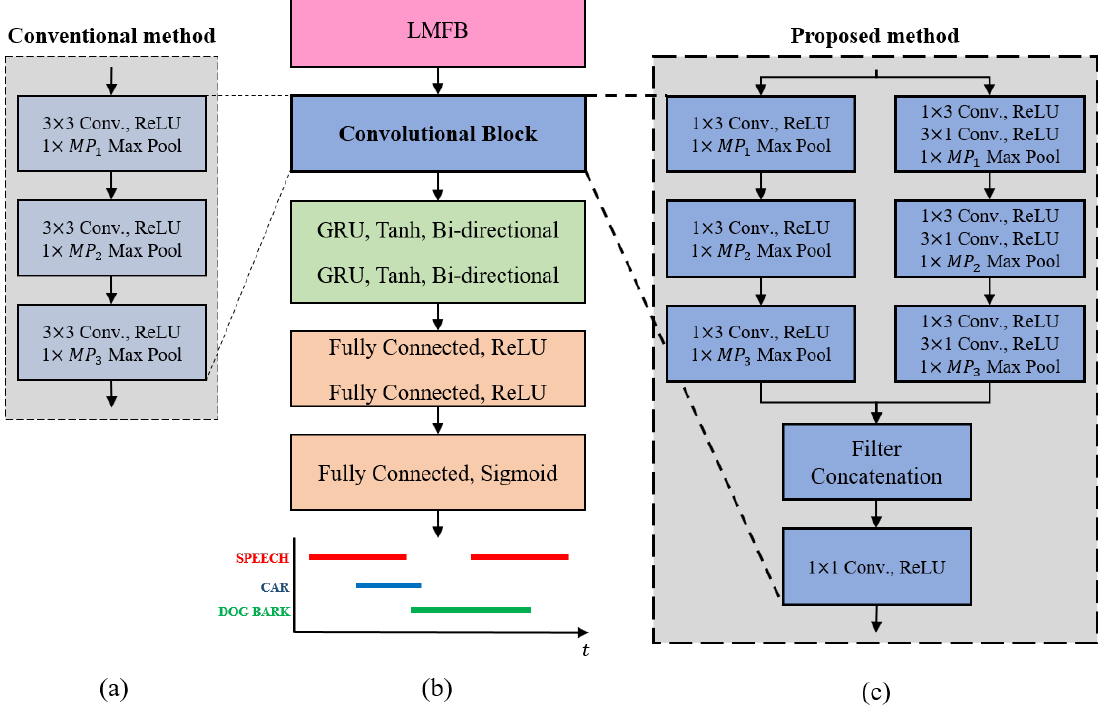
Figure 2. Overview of the SED model: ( a ) convolutional block of the Detection and Classification of Acoustic Scenes and Events (DCASE) 2019 Task 3 baseline [18]; ( b ) CRNN-based SED model; ( c ) proposed convolutional block. LMFB, log-scale Mel filter